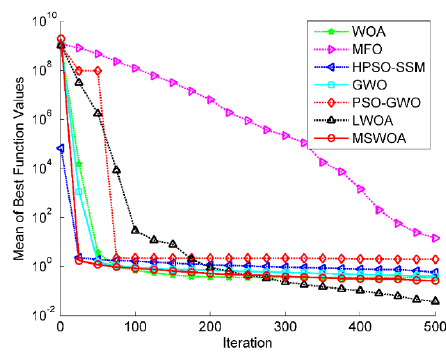
Figure 9. Optimization results for F11 (Dim = 30).